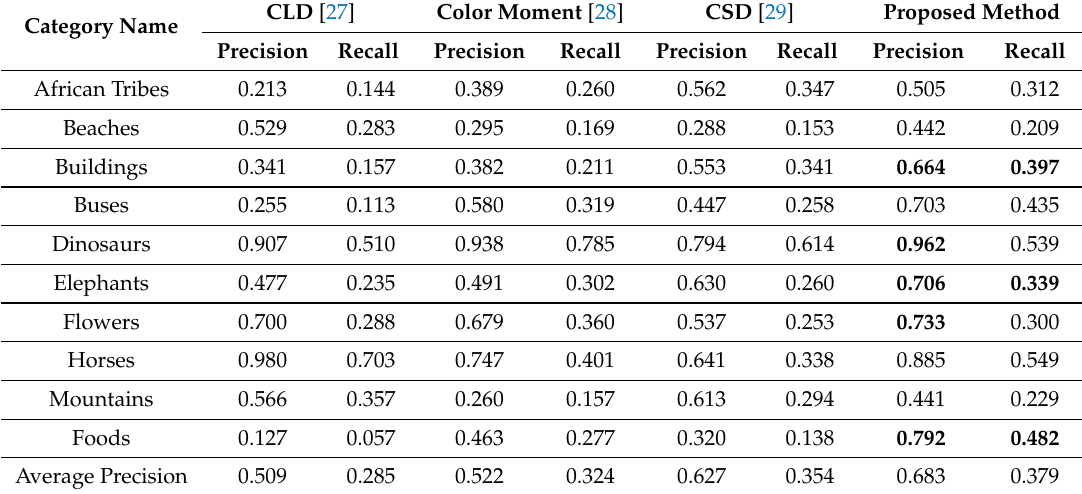
Table 2. Comparisons of precision and recall results among CLD, Color Moment, CSD and our Proposed